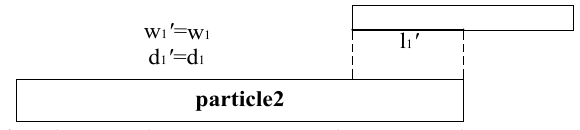
Figure 9. Schematic diagram of the projection step as plate2 is treated as the wall.